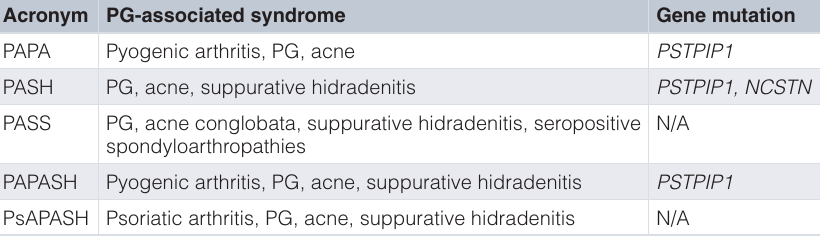
Table 1. Pyoderma gangrenosum (PG)-associated genetic syndromes and their specific gene mutations 4 . Acronym PG-associated